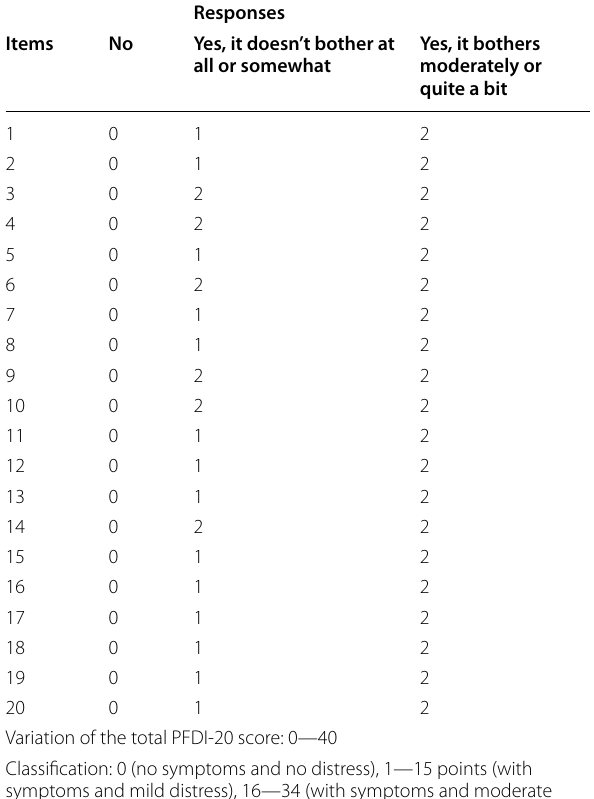
PFDI-20: Pelvic floor distress